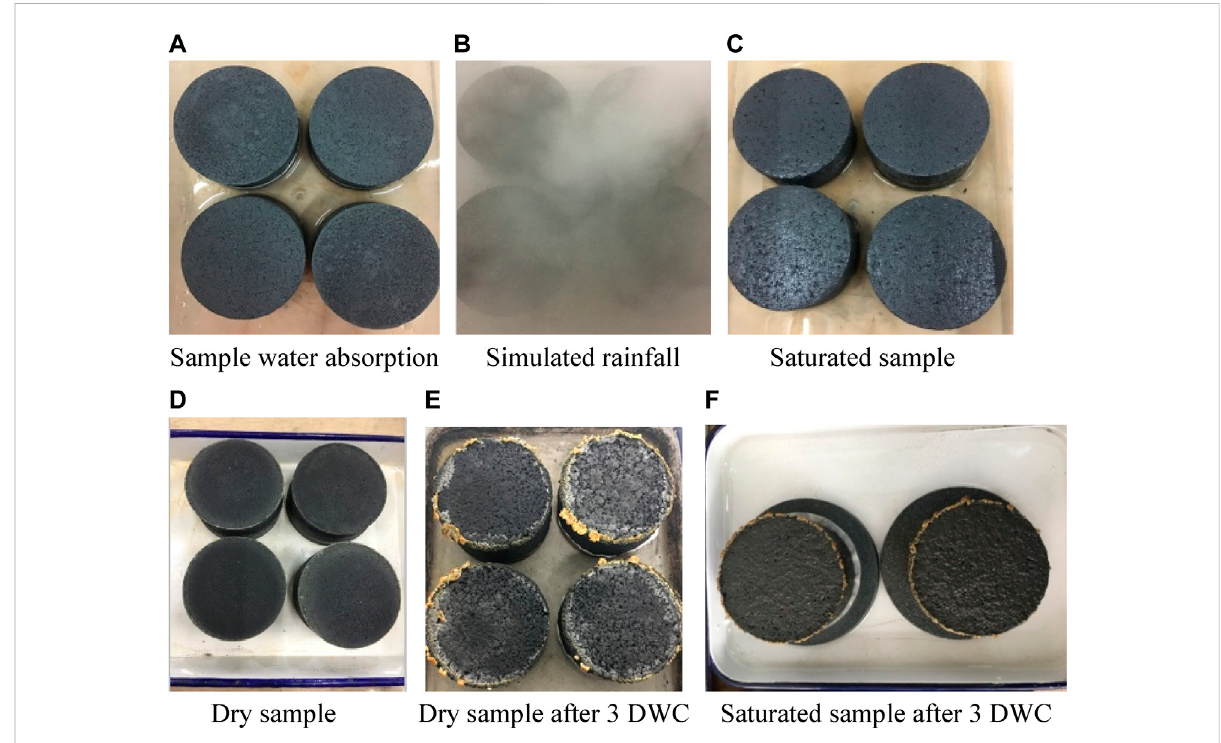
FIGURE 1 Thesurfacemorphologyofthelargeroundsampleswiththehygroscopic,dehumidifying,andafterthreeDWC. (A) Samplewaterabsorption